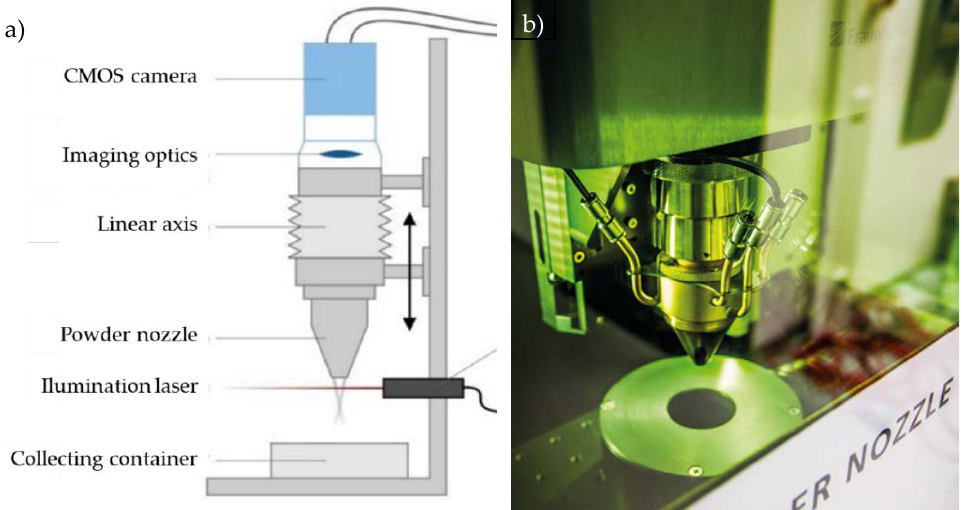
Figure 8. ( a ) Diagram of the experimental setup for measuring the powder-gas jet using the laser light-sectioning method. ( b ) Picture of the measuring device [1]. Reprinted with permission from Ref [1]. Copyright 2020, Fraunhofer